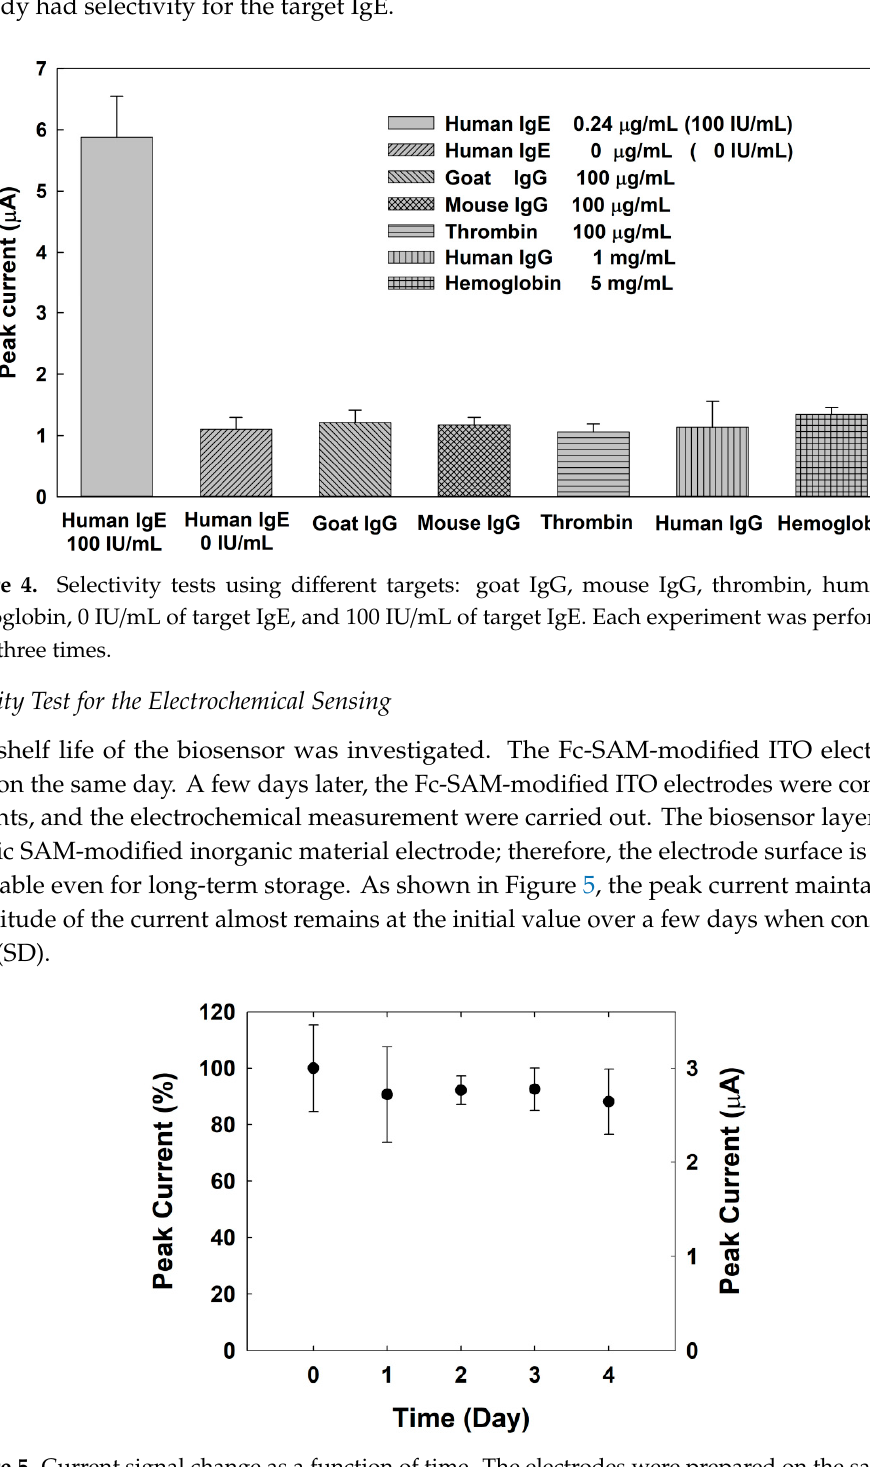
Figure 5. Current signal change as a function of time. The electrodes were prepared on the same day, but the bio-assay and electrochemical measurement were performed a few days later. The target IgE concentration was 10 IU / mL. Each experiment was performed at least three times.